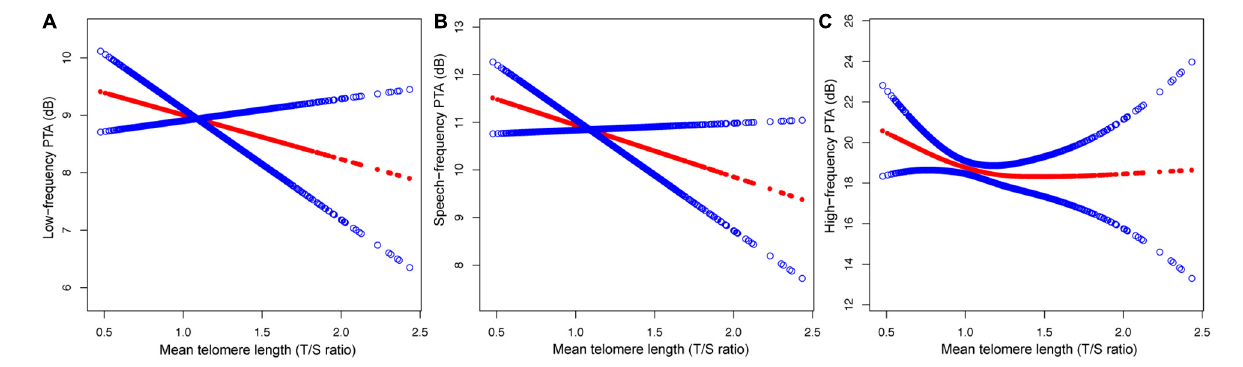
FIGURE 2 | The relationship between MTL and hearing threshold shifts: (A) low-frequency PTA, (B) speech-frequency PTA and (C) high-frequency PTA. TABLE 4 | The results of two-piecewise linear regression model between MTL and hearing thresholds. Exposure